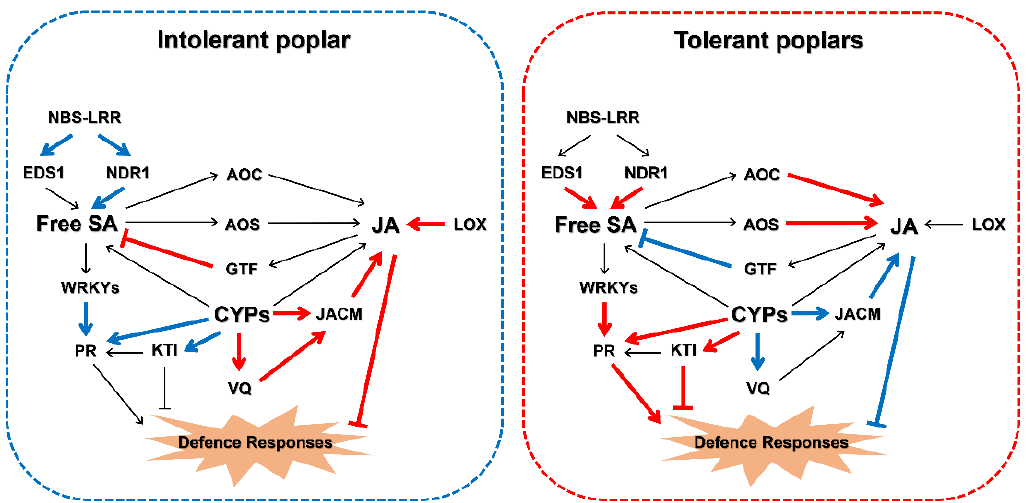
Figure 7. Model of how plant–pathogen interaction-related and signalling-related genes may interfere with E4 infection in tolerant and intolerant poplars. The bold red indicates that gene expression is specifically upregulated at a specific time point, and the bold blue indicates that gene expression is specifically downregulated at a specific time point. This specific time point is usually 2 hpi or 6 hpi for JA-related genes and 2 dpi or 4 dpi for SA-related genes. Normal black indicates that there is no significant difference in gene expression between the three poplars. NBS-LRR, NBS-LRR resistance gene-like protein; EDS1, enhanced disease susceptibility 1 family protein; NDR1, non-race-specific disease resistance 1 family protein; WRKY, WRKY transcription factor; PR, pathogenesis-related family protein; AOC, allene oxide cyclase 3, chloroplastic-like; AOS, allene oxide synthase family protein; LOX, lipoxygenase family protein; GTF, putative glucosyltransferase family protein; CYP, cytochrome P450 family protein; JACM, jasmonic acid carboxyl methyltransferase family protein; KTI, Kunitz-type trypsin inhibitor; VQ, VQ motif-containing family protein.